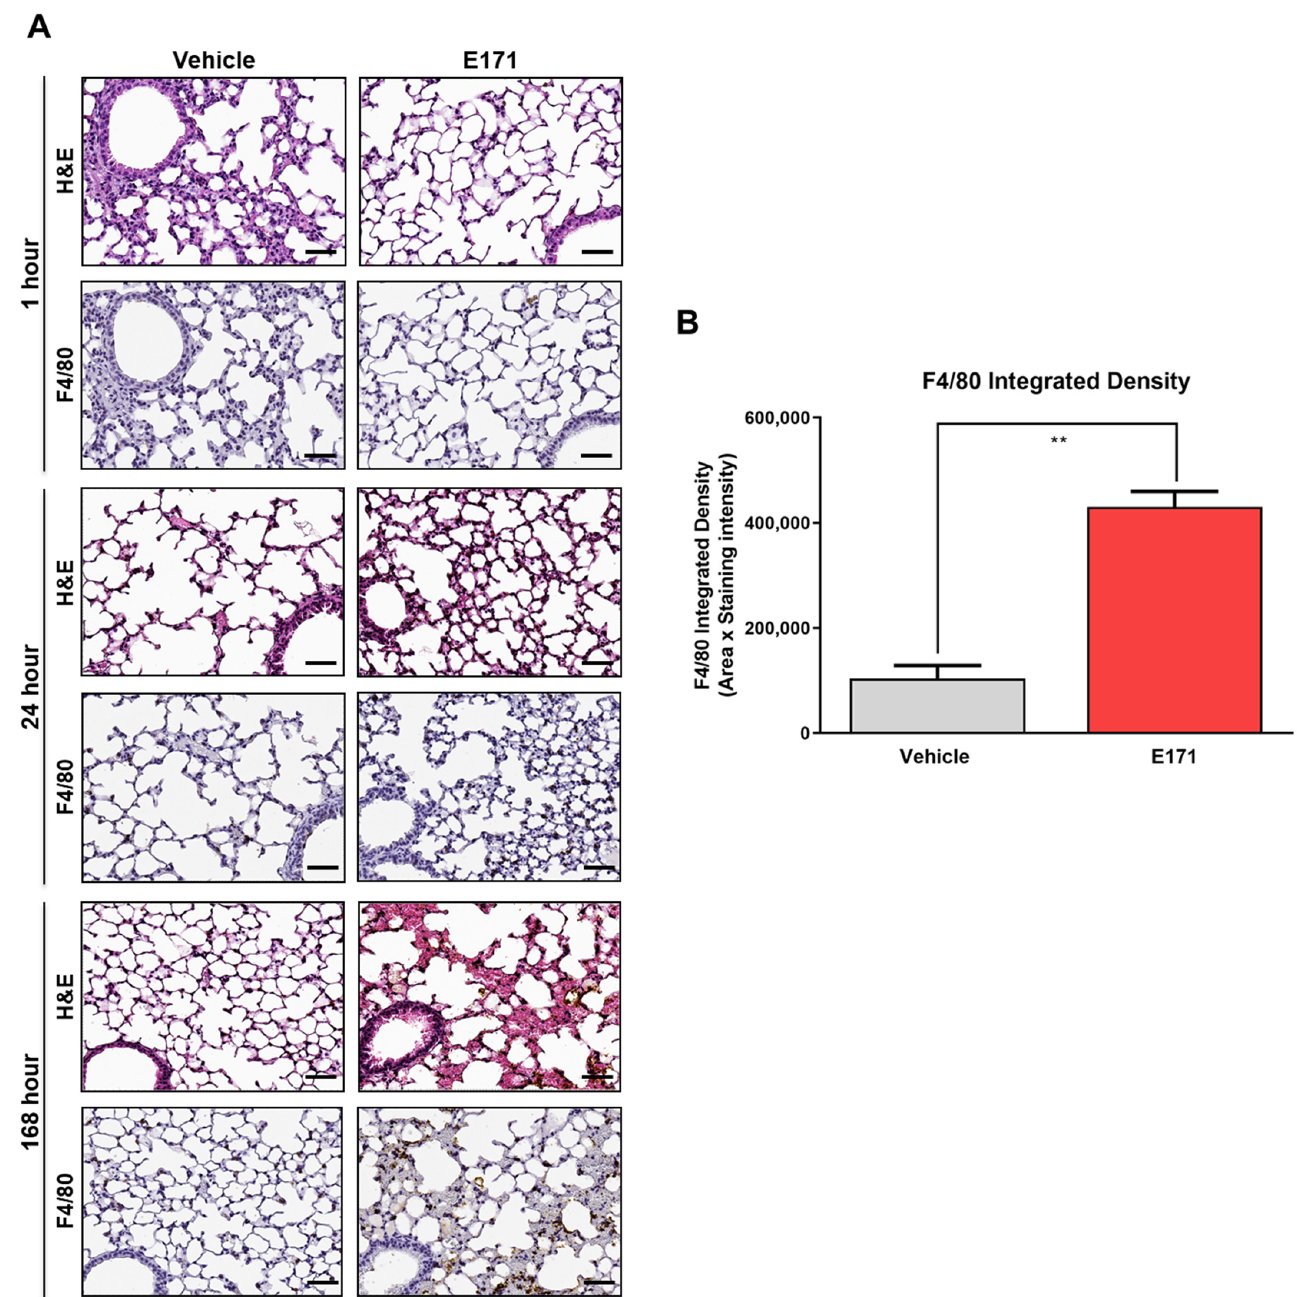
Figure 7. Pathological examination of the lungs of E171-injected mice. ( A ) Representative images of hematoxylin–eosin (HE) and F4/80 immunostaining of lung sections from mice treated with either vehicle or E171 and euthanized 1, 24, or 168 h after injection. ( B ) F4/80 immunoreactivity of slices from mice euthanized 168 h after treatment. Values are mean ± SEM (N = 5); ** p < 0.01 vs. vehicle, according to unpaired Student’s t -test. Scale bars = 50 μ m.